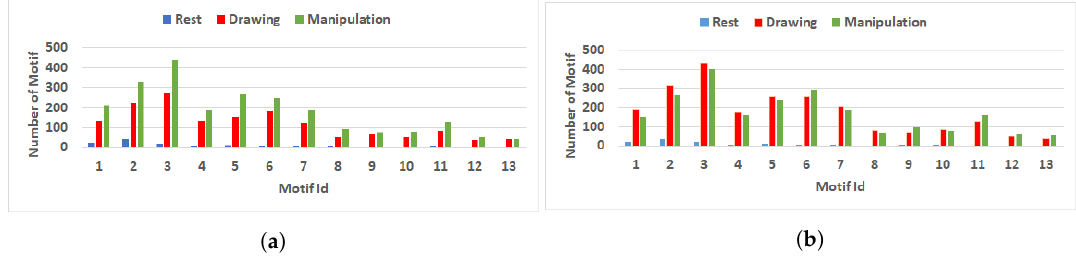
Figure 11. Comparison of number of motif with three nodes during rest, drawing and manipulation states. ( a ) User 3 (Novice user). ( b ) User 8 (Expert user).